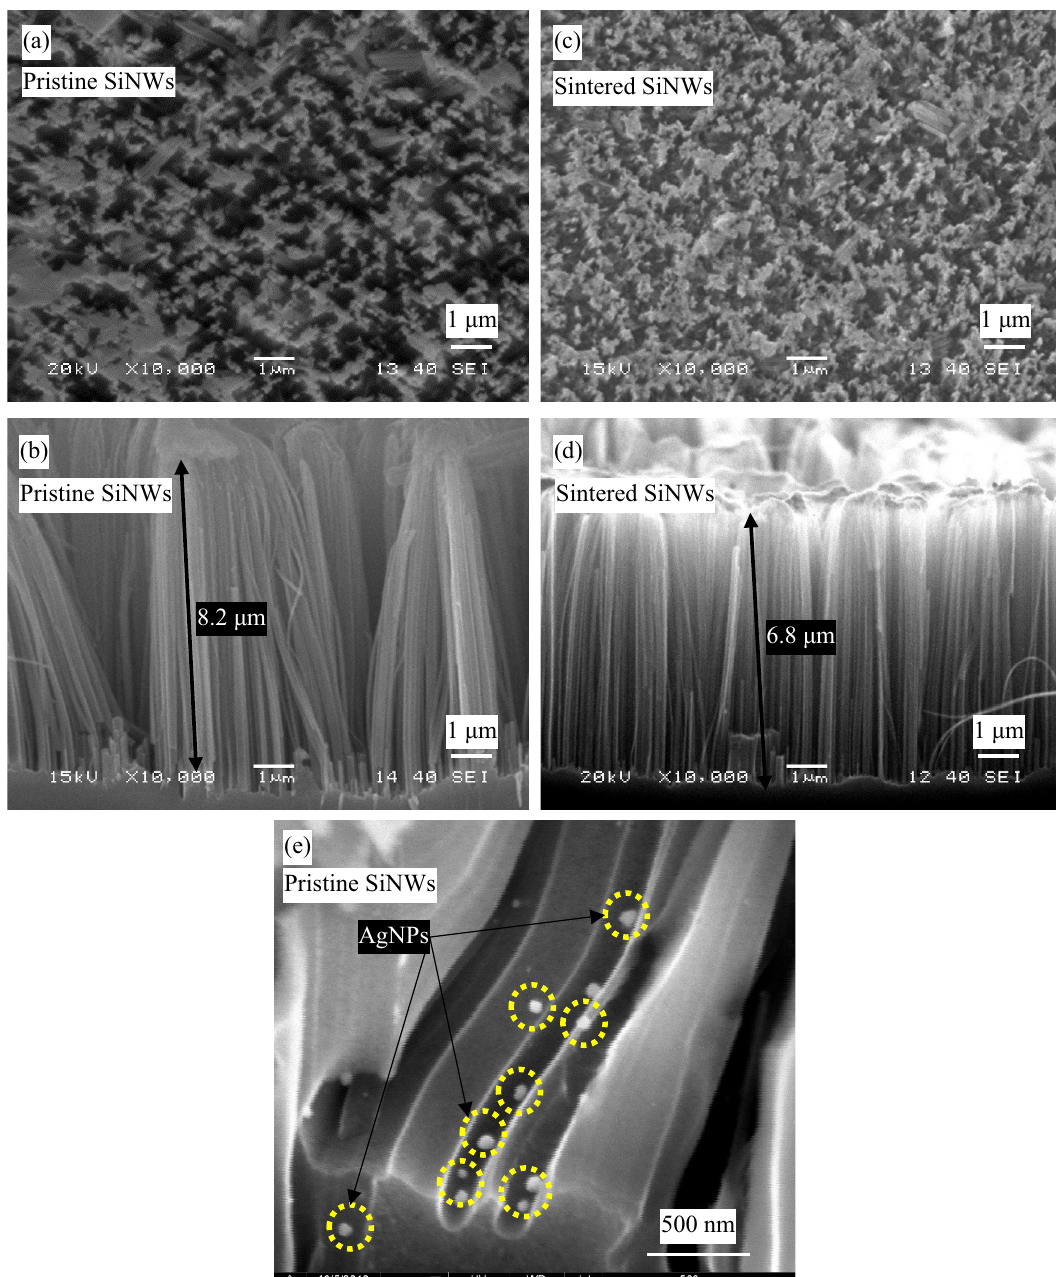
Figure 2. SEM image of SiNWs_0.01 sample ( a ) surface view, ( b ) cross-sectional view; and corresponding Res@1200 °C_SiNWs_0.01 ( c ) surface view, ( d ) cross-sectional view. ( e ) SEM image of SiNWs array showing the remanence of AgNPs inside the array after cleaning in HNO 3